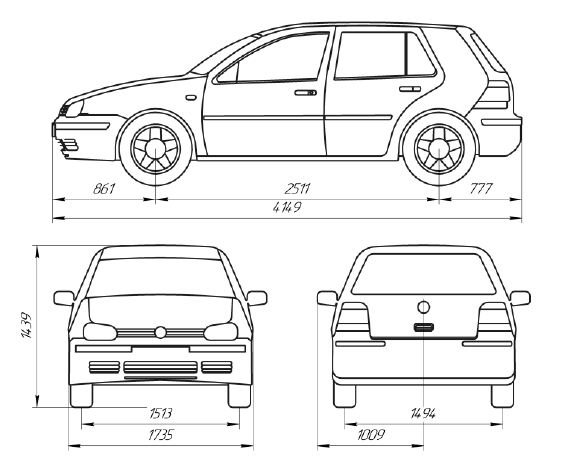
Fig. 2. Volkswagen Golf IV dimensions [19] Table 2. Volkswagen Golf IV technical specifications [19]